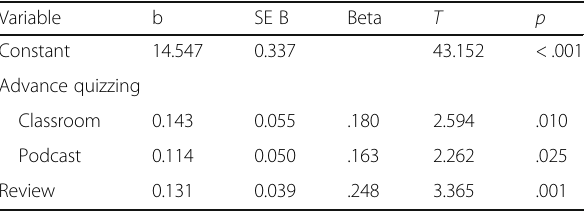
Table 4 Regression analysis predicting “ Introduction to Memory ” exam performance from advance quizzing and review in second-year students